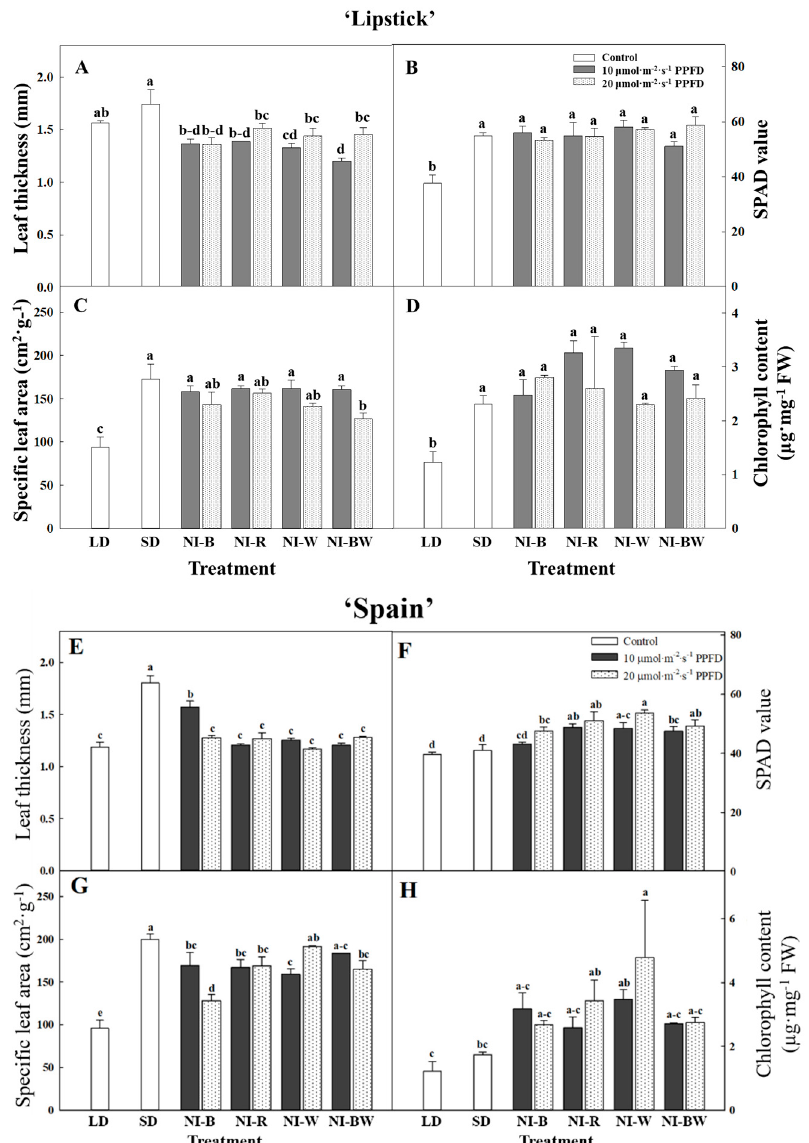
Plants 2019 , 8 , x FOR PEER REVIEW 7 of 15 Figure 3. The effects of the night interruption light (NIL) quality at 10 or 20 μ mol·m -2 ·s -1 PPFD on the leaf length (A and E), leaf width (B and F), number of leaves per plant (C and G), and leaf area (D and H) of kalanchoe ( Kalanchoe blossfeldiana ) ‘Lipstick’ and ‘Spain’ measured 98 and 71 days after treatment initiation, respectively. Please refer to Figure 1 for details on the NIL quality. Vertical bars indicate the means ± S.E. (n=3). Values followed by different letters are significantly different by the Duncan’s multiple range test at P ≤ 0.05.